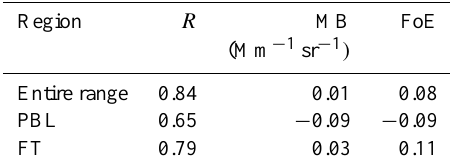
Table 3. Statistics of CALIOP and EARLINET agreement within the PBL and the FT using data